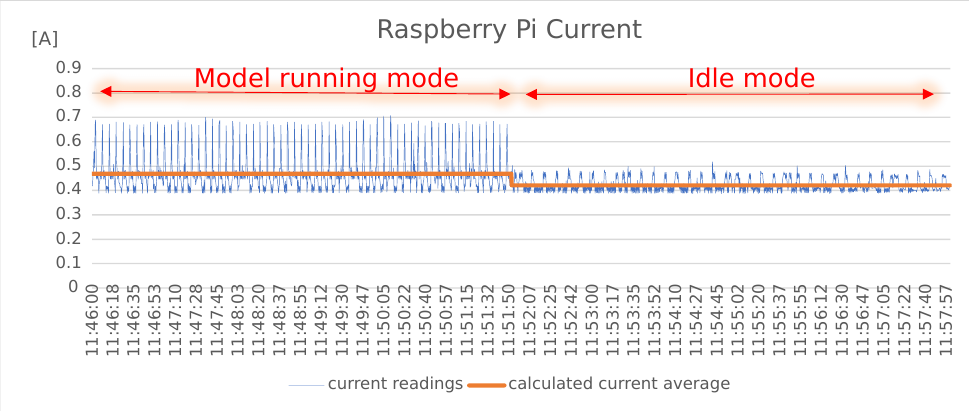
Figure 16. Variation in current consumption for ML model in Raspberry Pi; (y → current [A], x →